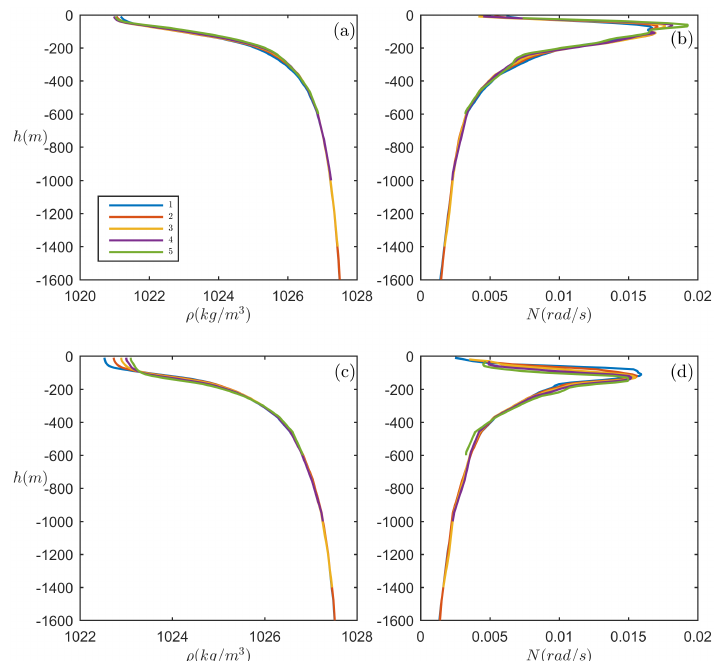
Figure 5. Background density and buoyancy frequency distribution along the transect of the South China Sea case. ( a , b ) are situations in summer, while ( c , d ) are in winter. Five different lines in each panel represent situations on the chosen five points along the wave propagation transect.